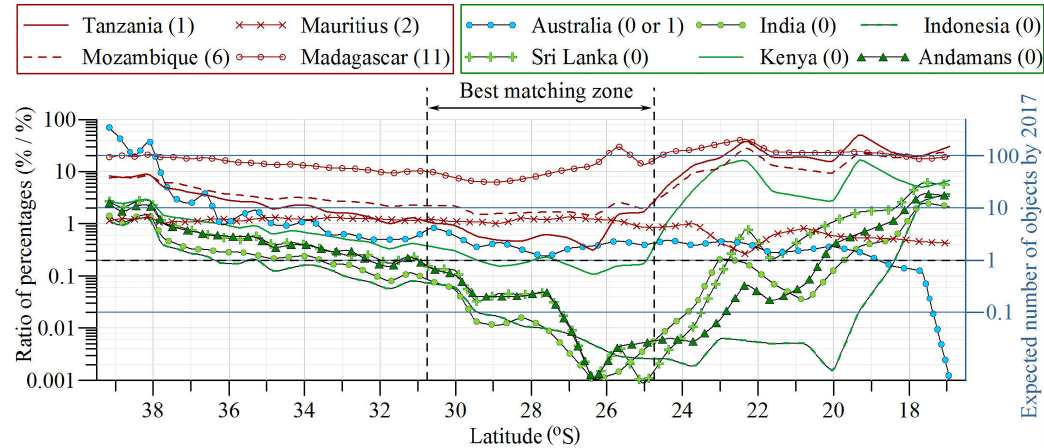
Figure 10. Expected number of objects to be found in several countries by 31 December 2016 vs. origin’s